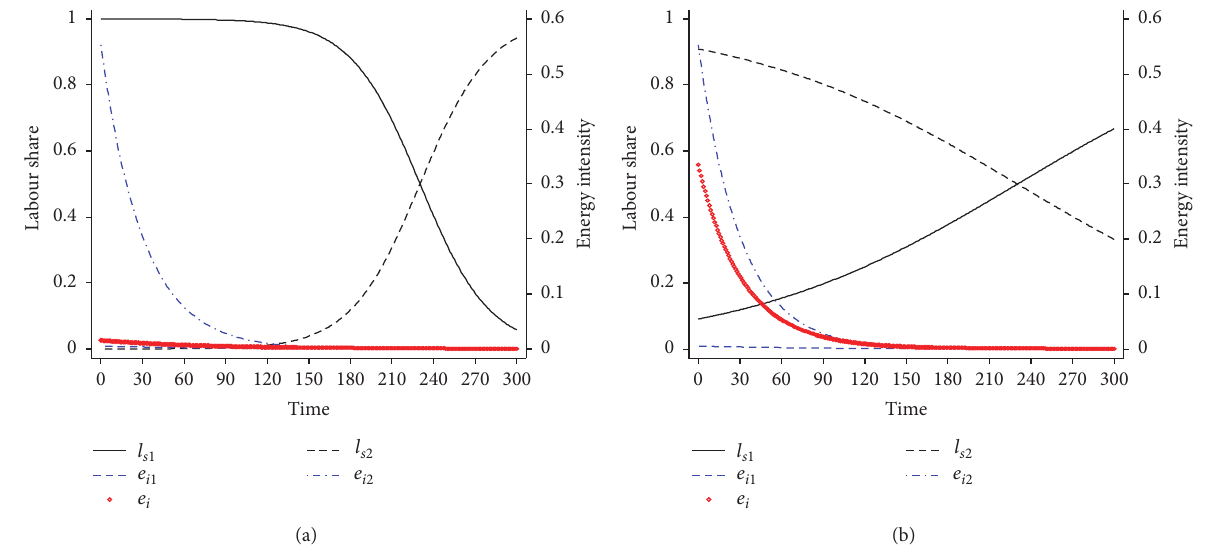
Figure 2: Decreasing trend of economy-wide energy intensity with low energy technological growth rate, (a) 𝜀 = 3 and (b) 𝜀 = 0.5